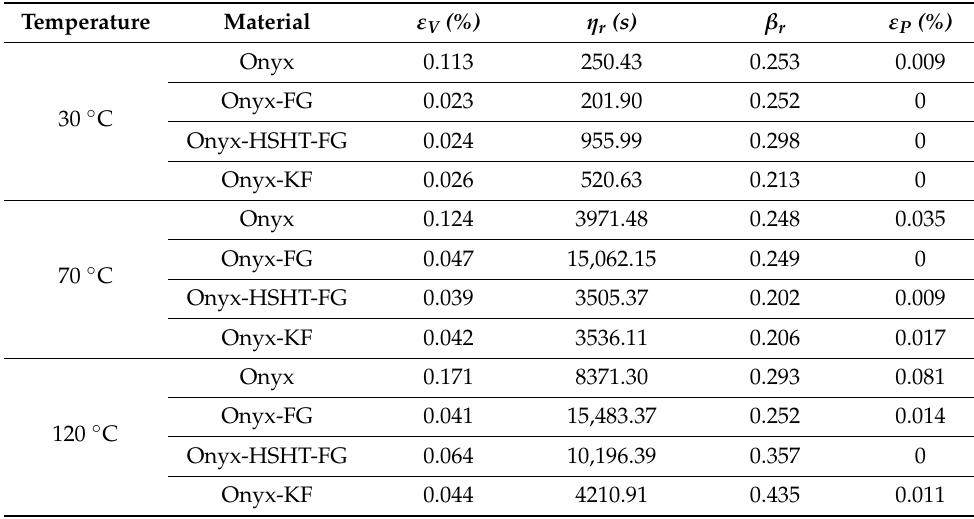
Figure 6. Modeling of creep recovery curves for CFR3DP composites at different temperatures; ( a ) Modeling of creep recovery for Onyx; ( b ) Modeling of creep recovery for Onyx-FG; ( c ) Modeling of creep recovery for Onyx-HSHT-FG; ( d ) Modeling of creep recovery for Onyx-KF. Table 3. Simulated parameters of the Weibull distribution function.